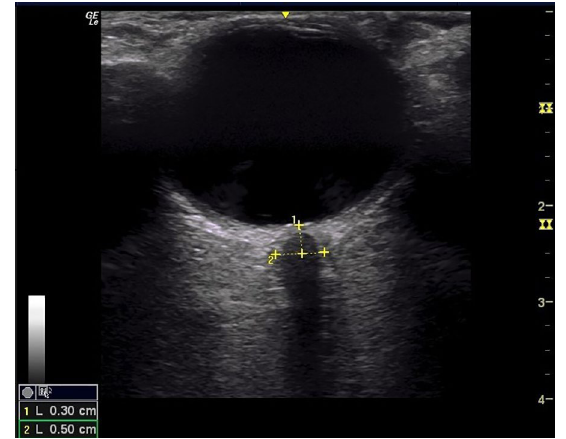
Fig. 1 ONSD ultrasound. The ONSD is measured 3 mm behind the retina, from which point a transverse line is drawn from the inner edge to the inner edge of both vertical hypoechoic lines (inner edge of the dura mater)